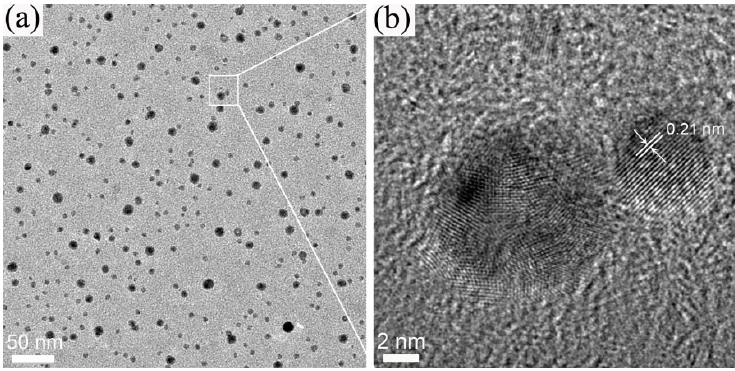
Figure 2. ( a ) Transmission electron microscopy (TEM); and ( b ) high ‐ resolution TEM (HRTEM) images of the carbon dots (CDs) prepared by hydrothermal treatment of lignin.